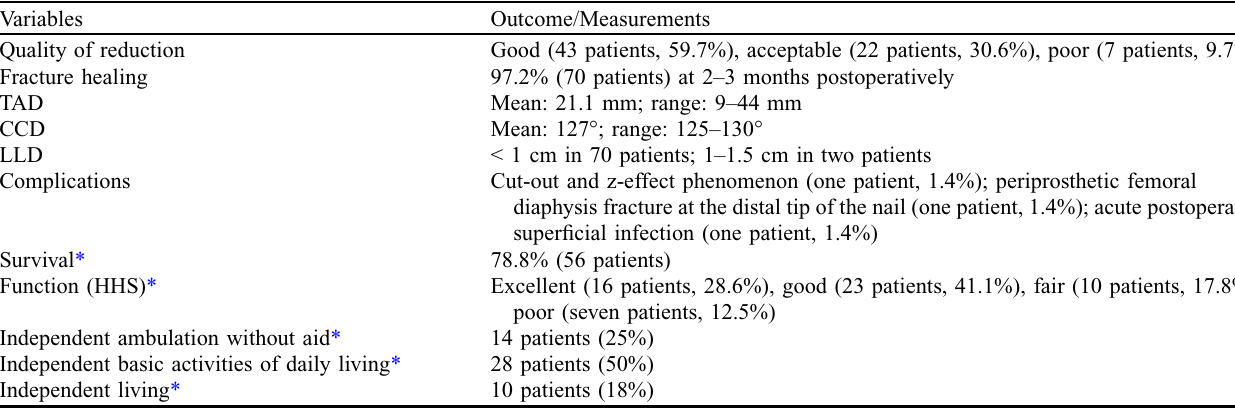
Table 1. A summary of the results of the patients included in this